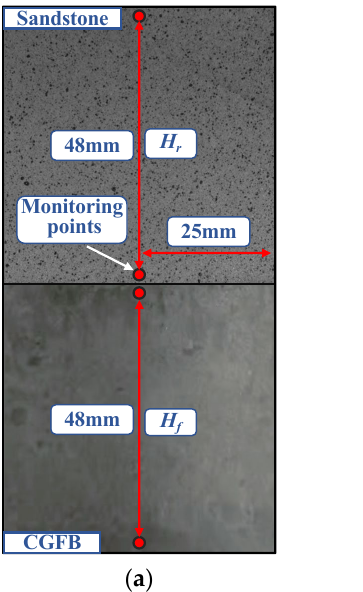
Figure 16. Layout of monitoring points for displacement differences between upper and lower ends of sandstone and CGFB samples. ( a ) Vertical direction; ( b ) horizontal direction.